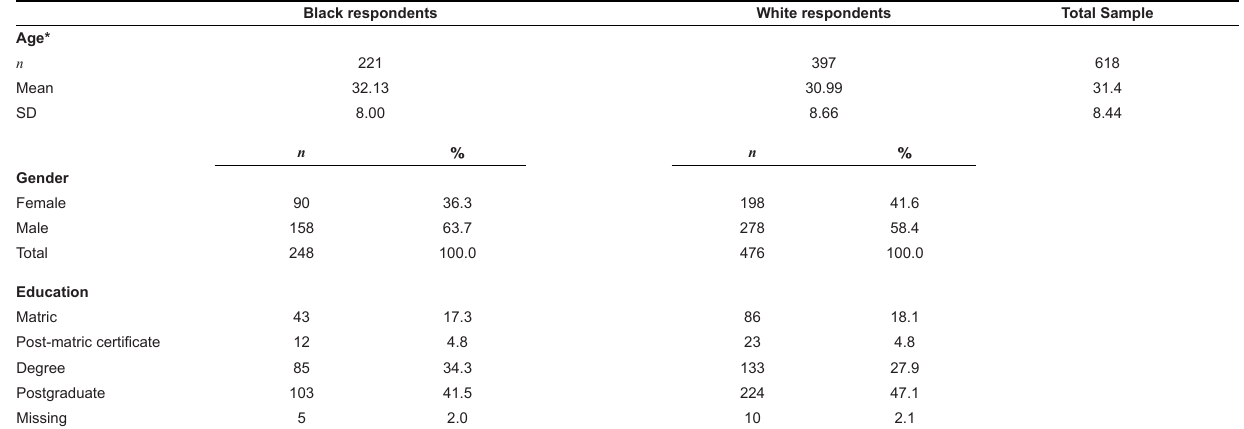
Table 1 Biographical information for the White and Black groups ( N =